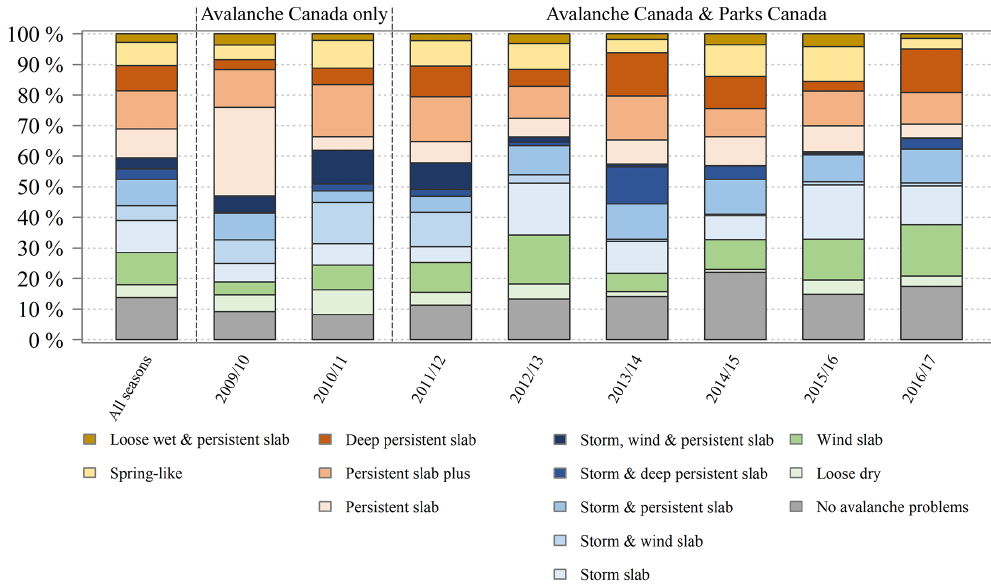
situations ( + 5 percentage points) and fewer Spring-like haz- ard situations ( − 4 percentage